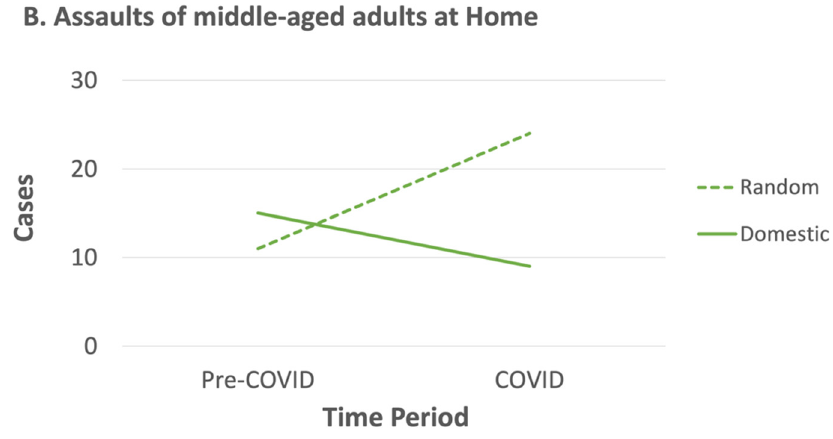
Figure 5. Change in assault-related TBI cases by location of injury between the pre-COVID and COVID periods: ( A ) across all locations of injury (** significant adjusted residuals at p < 0.05, FWE corrected); ( B ) across random and domestic assault groups at home in middle-aged (40–59 years old) adults. Table 3. Assault-related TBI cases by location of injury during the pre-COVID and COVID periods.